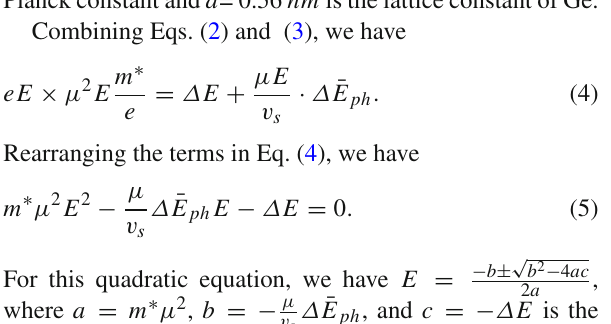
using L th = v th × τ th , where v th is thermal velocity of